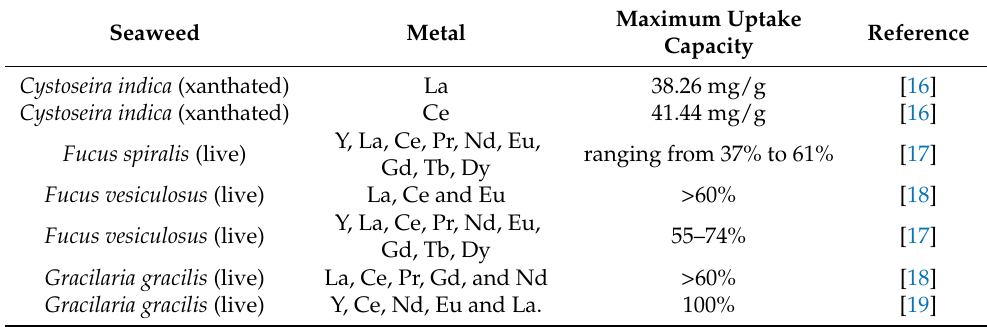
Table 2. Seaweed-based strategies for the recovery of critical raw